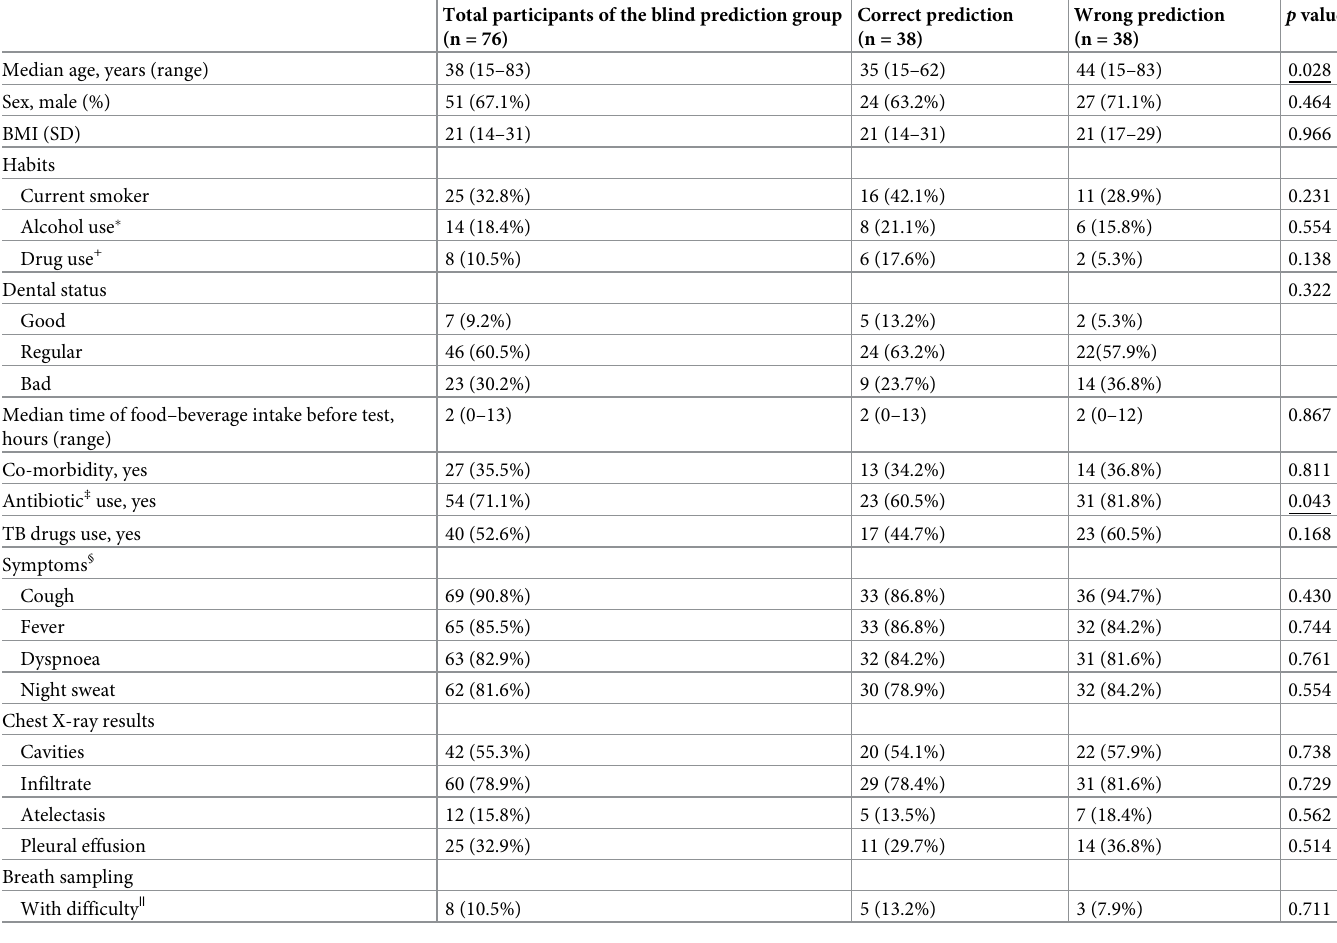
Table 3. Participant characteristics of the correct prediction group versus the wrong prediction